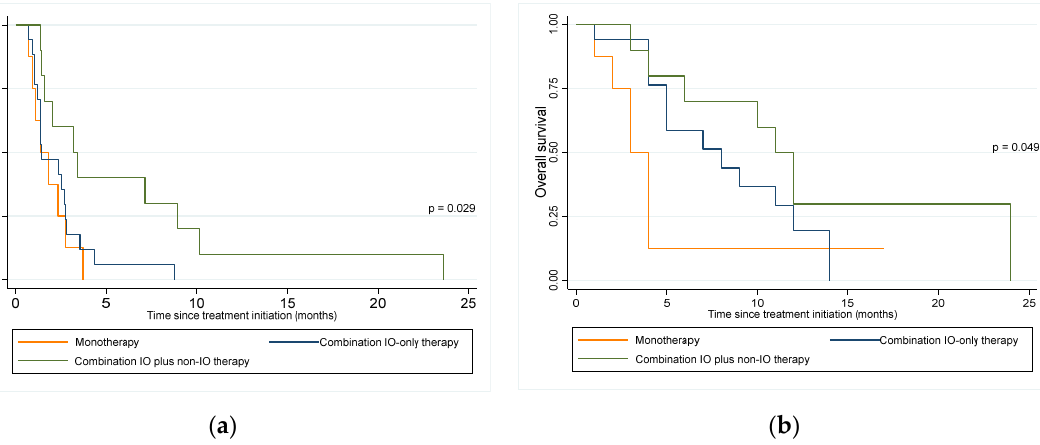
Figure 3. Kaplan–Meier survival curves. ( a ) Progression-free survival based on drug regimen; ( b ) Overall survival based on drug regimen. IO = immune-oncology.